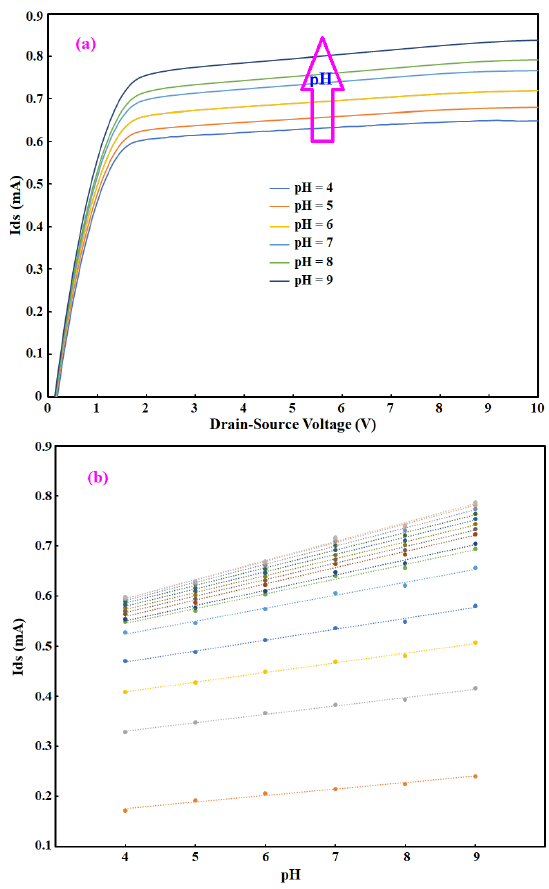
Figure 8. Drain-source voltage graphs for different pH values for OG-JFET at Vg = 0. ( a ) Ids-Vds curve for different pH values. ( b ) The current sensitivty for different values of Vds.